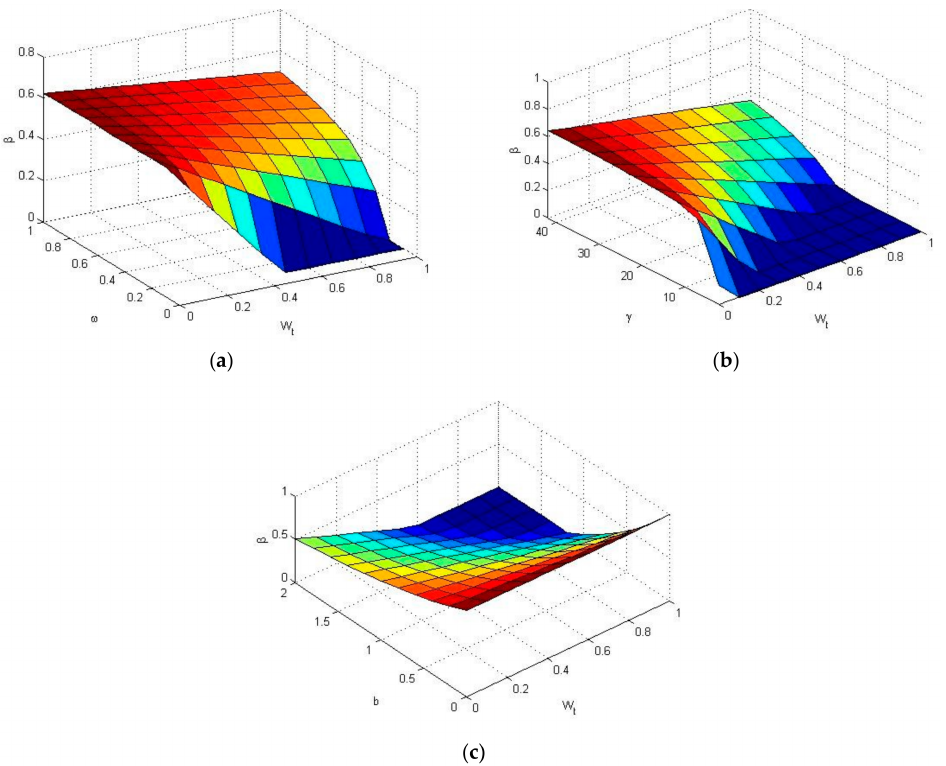
Figure 5. The economic development level and OPPSC under ( a ) different proportions of land increment income in land transfer fee, ( b ) different expected return rates of the stock capital and ( c ) different marginal utility elasticities of the lump-sum currency